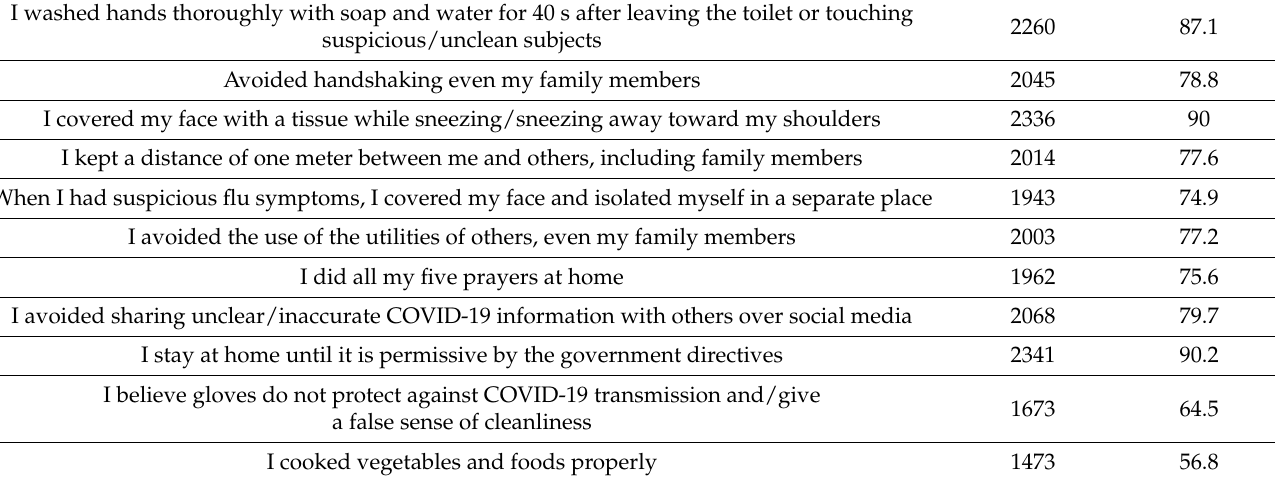
Table 3. Which of the below recommendations by MOH did you comply with? n =